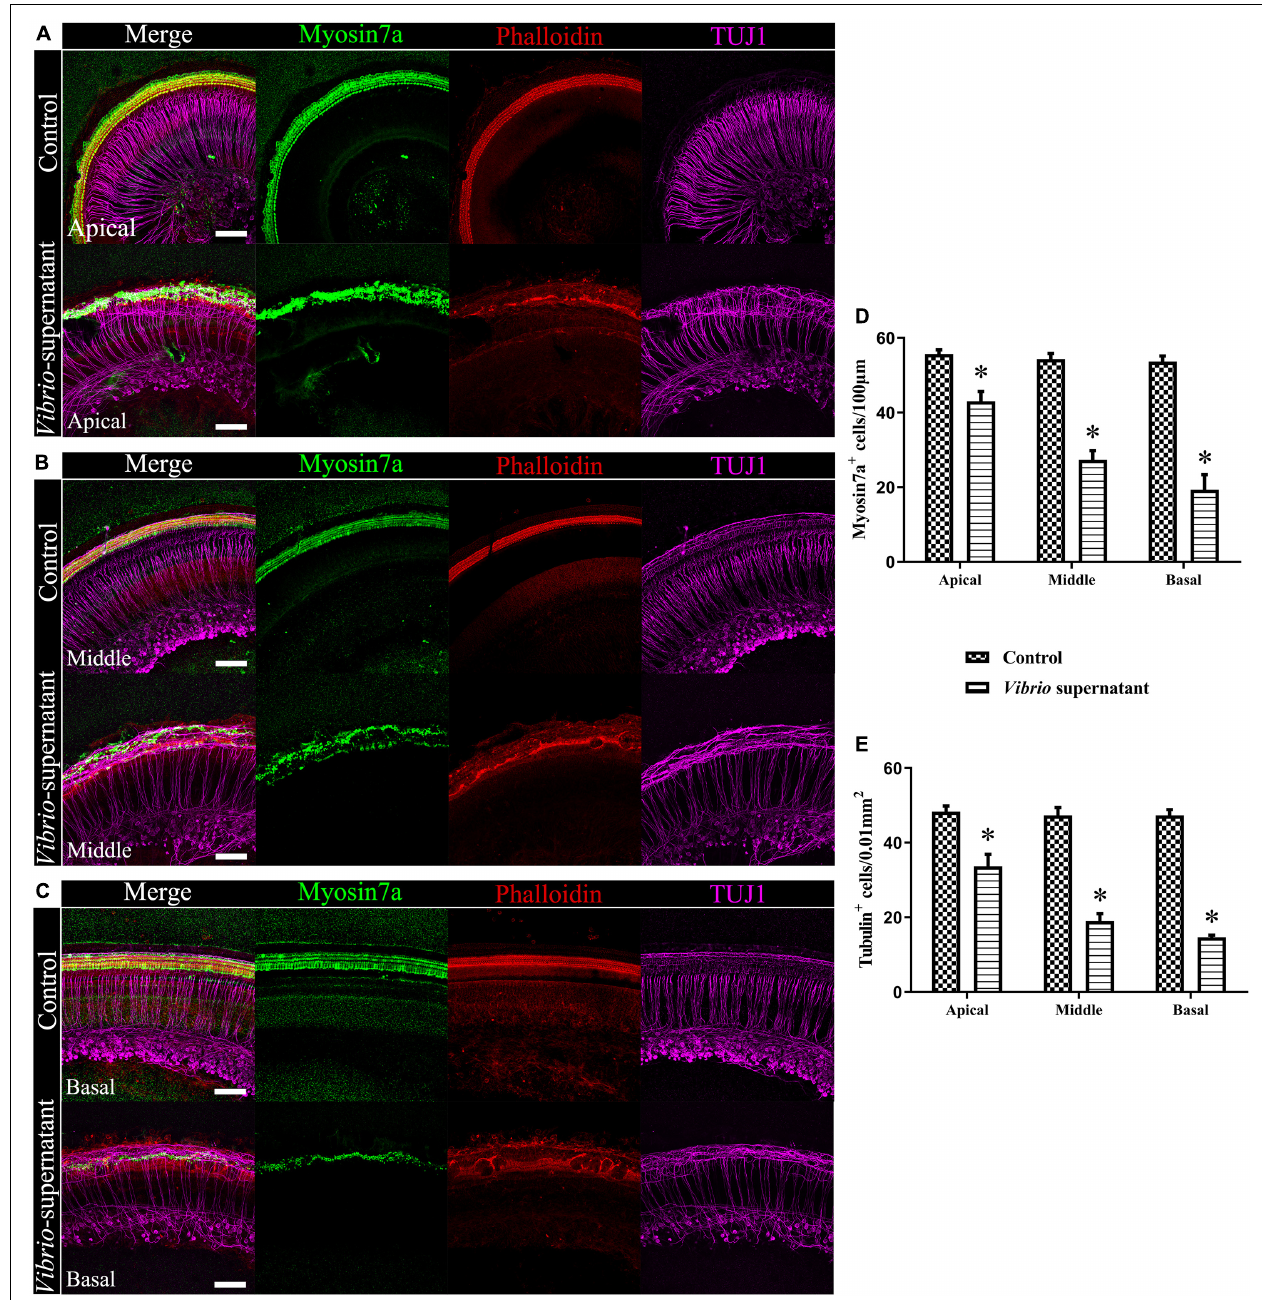
FIGURE 5 | Ototoxic effects on cochlear organotypic explant cultures induced by Vibrio alginolyticus . Ototoxic damage was observed at the apical (A) , middle (B) , and basal (C) turns of the cochlear explants. The numbers of Myosin 7a + , phalloidin + hair cells (HCs) (D) , and β -III Tubulin (TUJ1) + spiral ganglion neurons (SGNs) were quantified (E) . The results are expressed as the mean ± standard deviation (SD) ( ∗ p < 0.05, vs. control). Scale bars = 100 µ m.